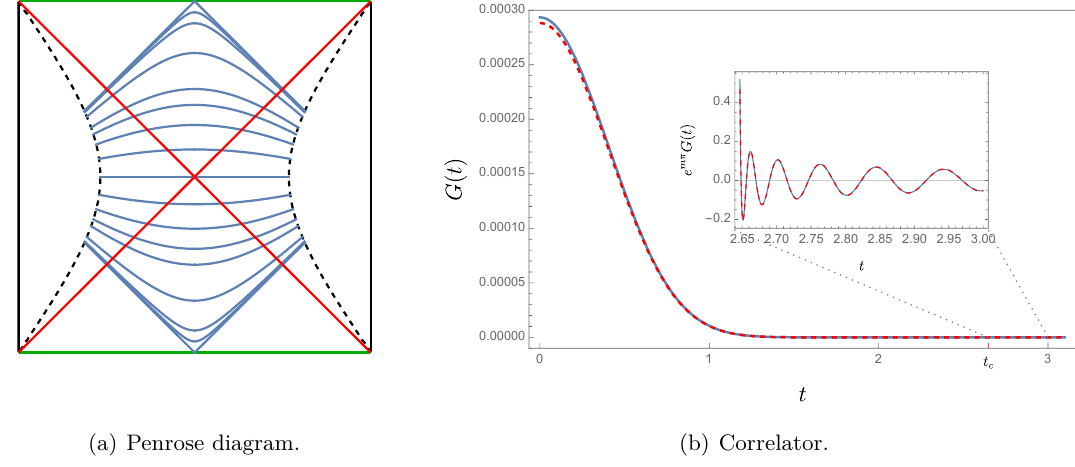
Figure 3 . (a) Penrose diagram showing the geodesics (in blue) between two stretched horizons (in dashed black). The position of the stretched horizon is set to r st = 2 / 3 . (b) Exact (dashed red) and large mass (solid blue) correlator for two symmetric points on opposite stretched horizons as a function of the static patch time. At early times we observe a decay of the correlation function while at later times we observe an oscillatory behaviour. We multiply by e mπ in the inset to make the oscillations apparent. In the plot, m = 20 and r st = 0 . 99 , so t c ∼ 2 . 65 . Given the stretched horizon is very close to the actual horizon, at t ∼ 0 , the two points become very close to each other, and so the approximation breaks